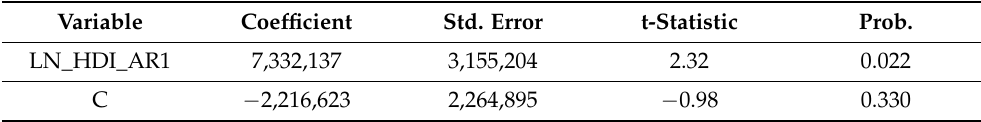
Table 5. Estimation for Argentina.